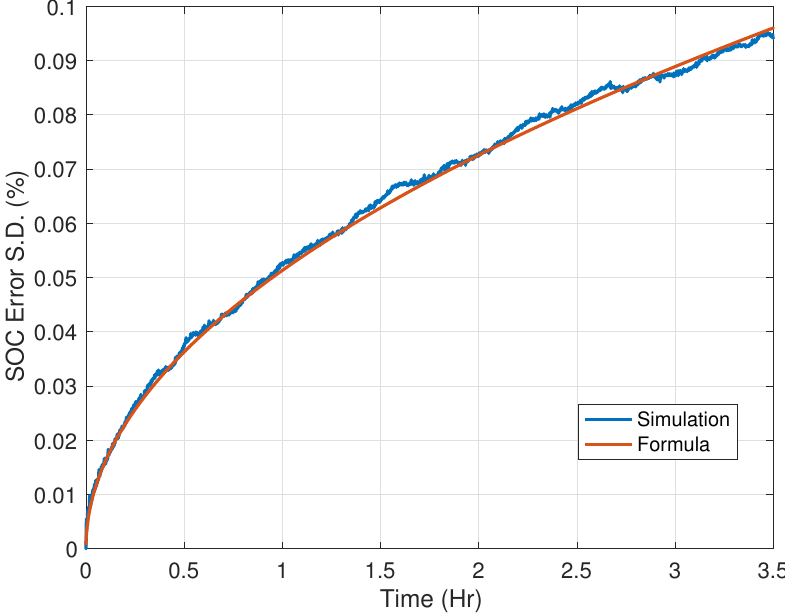
Figure 9. The standard deviation of SOC error because of the current integration error. The red curve is the theoretical value of the s.d. σ s,I ( k ) derived in (46); the blue curve shows ˆ σ s,I ( k ) , the s.d. obtained through Monte Carlo simulation as shown in (93). The constant κ is computed through empirical methods to be κ = 0.88. It must be noted that κ varies for different types of current